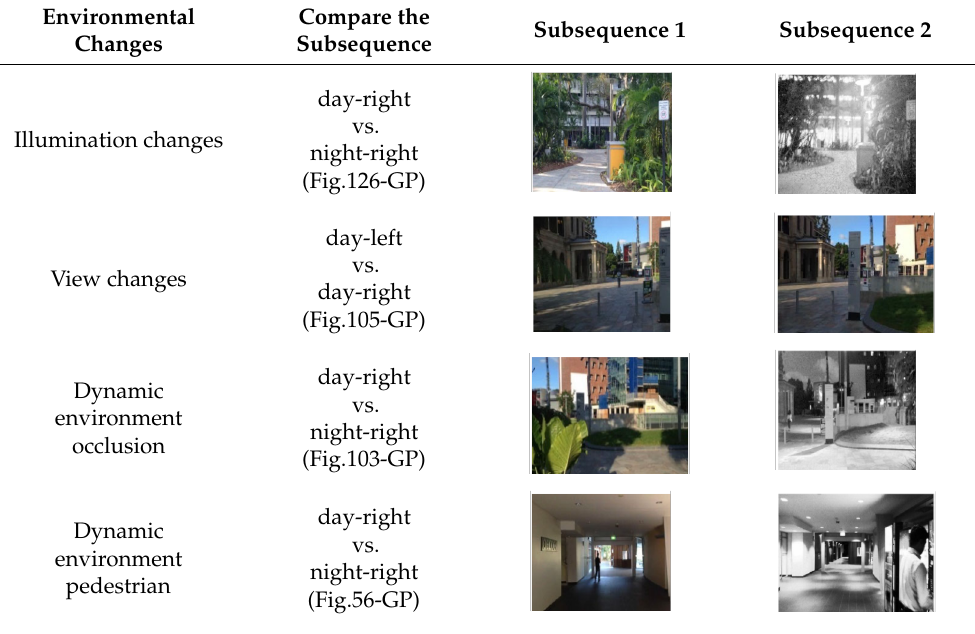
Table 1. The Gardens Point dataset.